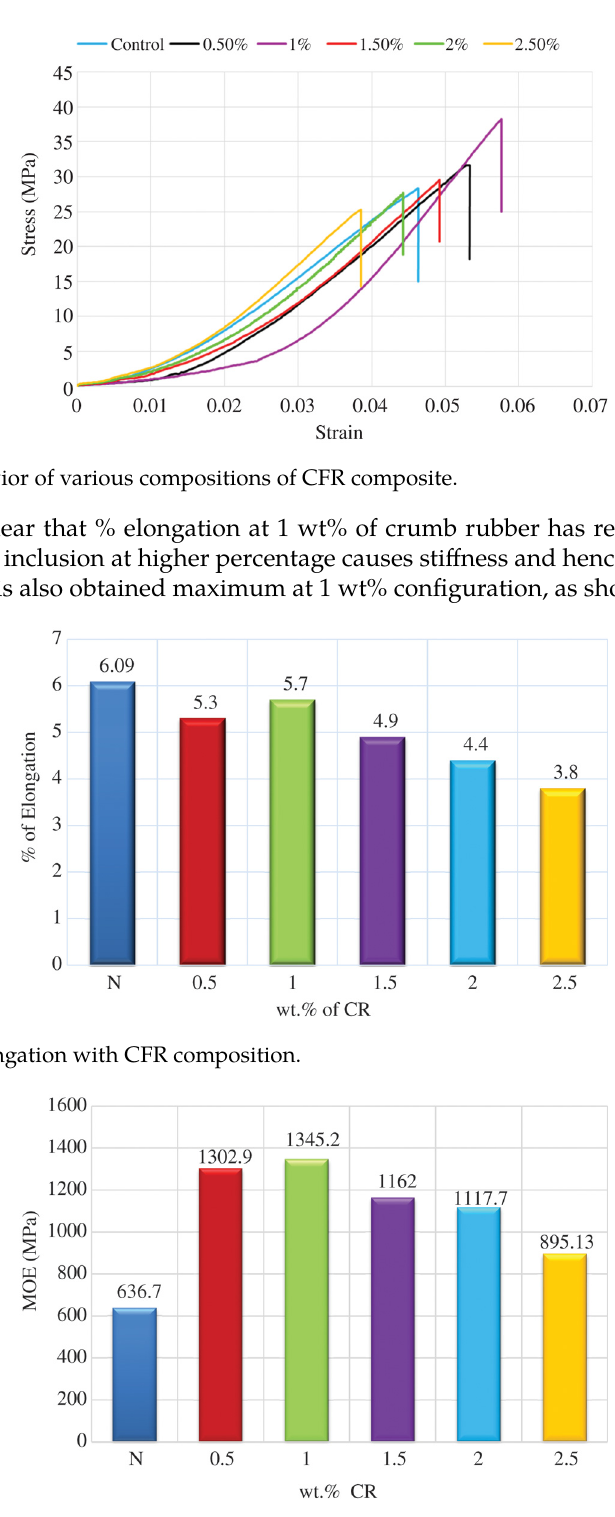
Figure 19: Variation of modulus of elasticity with CFR